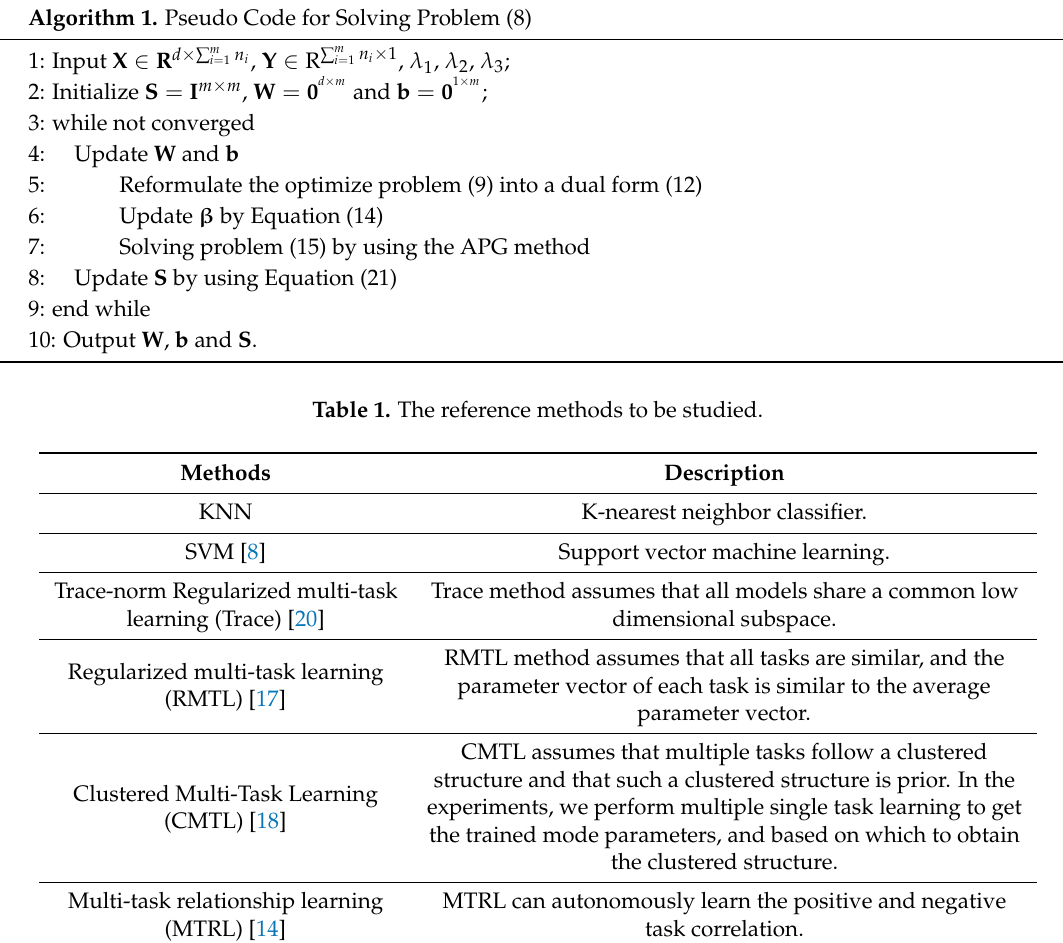
Figure 1. Illustration of proposed method. Firstly, m tasks are formed by concatenating the m targets. In each of the task, the first target is considered as positive sample, and the others negative ones. Then, multi-task learning is performed under the constraint of objective function Equation (8). After training, the multi-task relationships and clustered structures are obtained by Equation (21). In the figure, tasks with similar colors are similar with each other. Finally, the decision is reached by the obtained nonlinear predictive function Equation (22). Algorithm 1. Pseudo Code for Solving Problem (8)